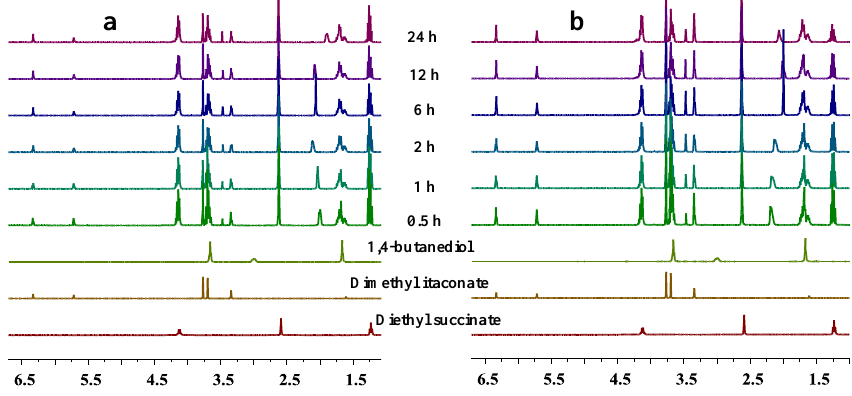
Figure 3. In situ 1 H-NMR investigation of the oligomerization process of: ( a ) diethyl succinate (35%), dimethyl itaconate (15%) and 1,4-butanediol (50%); ( b ) diethyl succinate (25%), dimethyl itaconate (25%) and 1,4-butanediol (50%).